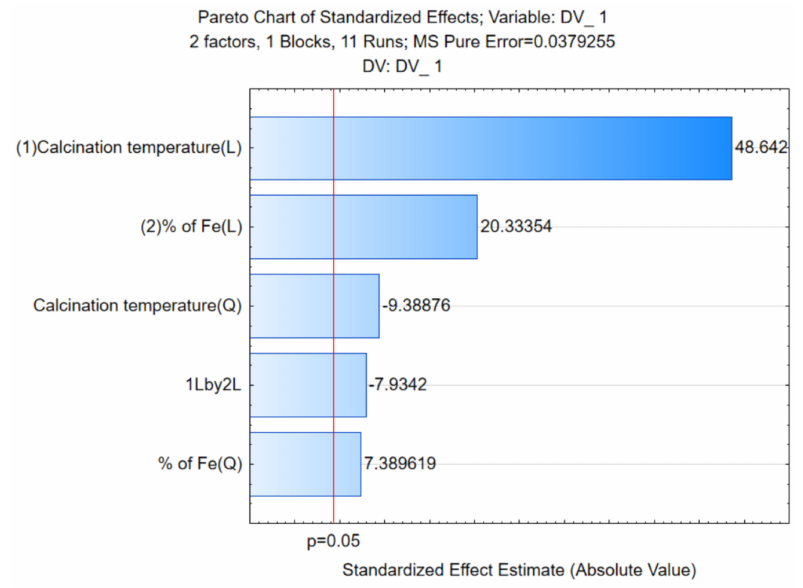
Figure 10. Pareto chart (pH = 7.0, 1 g L − 1 , and 20 min of